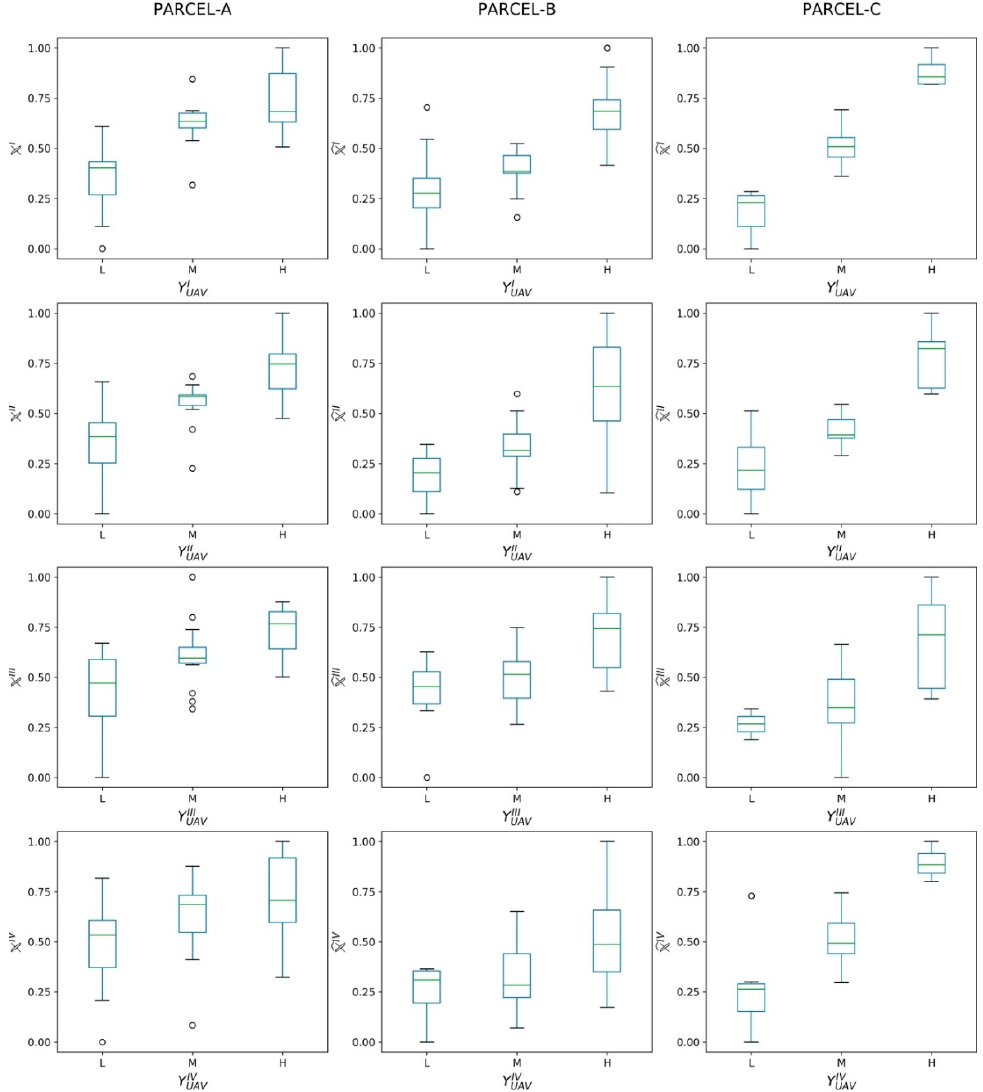
Figure 5. Pixel groups boxplots from refined satellite maps ( ˆ X I , ˆ X II , ˆ X III , and ˆ X IV ), clustered according to the three vigor classes “L”, “M”, and “H” defined in the UAV-driven clustered maps Y I , Y II , Y III , and Y IV , respectively. The boxplots are computed individually for each parcel ( A , B , and C